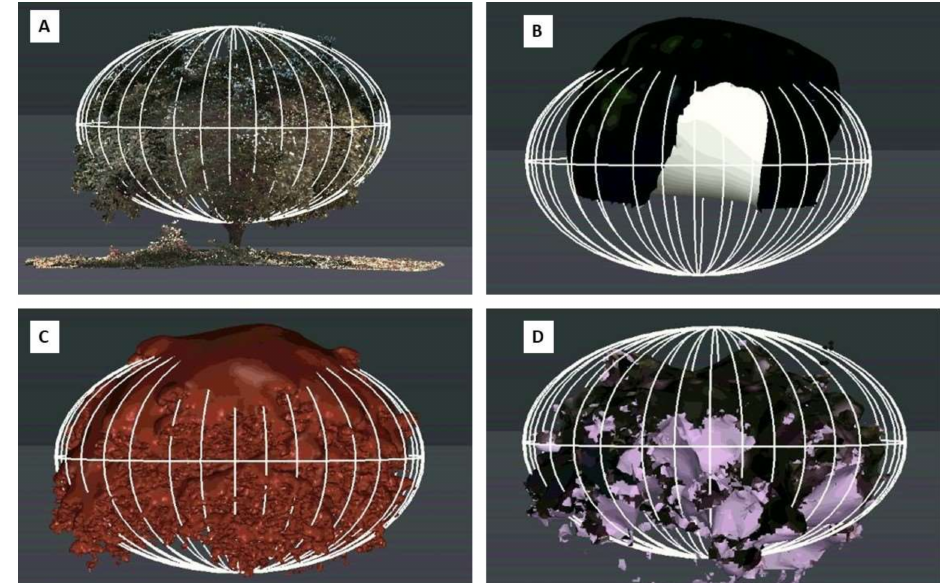
Figure 15. Visual assessment of the di ff erent methods for tree 7. ( A ) TM vs. tree. ( B ) UAV vs. TM. ( C ) HDS vs. TM. ( D ) GM vs. TM.